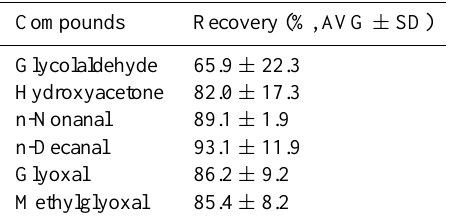
Table 1. Recoveries (%) of authentic carbonyls from BHA impreg- nated filter.